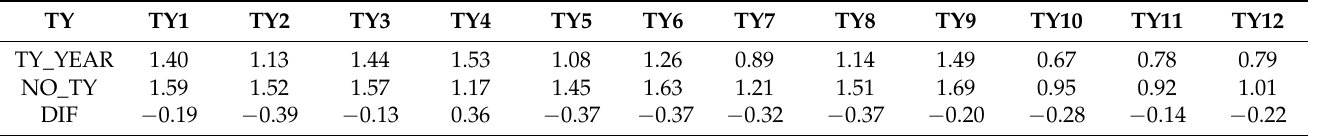
Table 5. Mean ABLH (in km) of each typhoon in Figures 7 and 8 (TY_YEAR row) and the mean ABLH over the region of each typhoon derived from the ABLH climatology (the ABLH in the year of the typhoon was excluded; NO_TY row). The DIF row shows the difference between TY_YEAR and